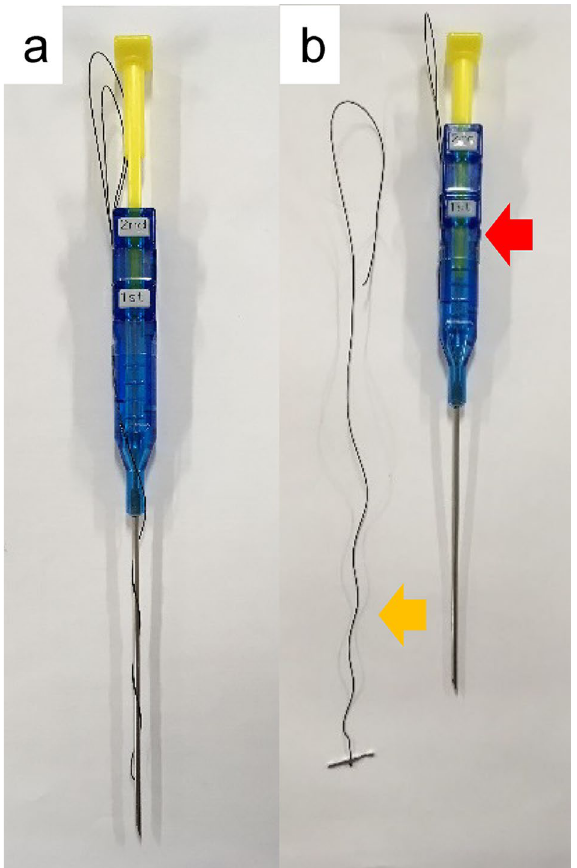
Figure 1. Two-shot anchor device containing a thread with metal bar attached (T-bar), containing two threads within one guiding needle, each thread having a metal bar. ( a ) Two shot anchors before puncturing and ( b ) button (red arrow), which is pushed to separate the thread with the T-bar from the tip of the device (yellow arrow).